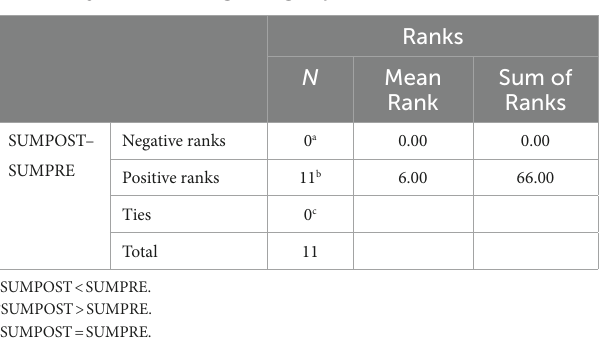
TABLE 6 Positive, negative, and tied paired differences in PST self-efficacy scores for self-guided group.